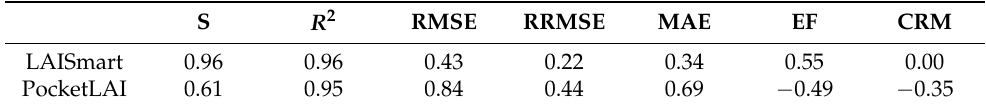
Figure 4. The Q-Q plot of two smartphone sensor methods with the LAI-2000 instrument. The similar quantile-quantile plot around y = x line of LAISmart and LAI-2000 ( a ) indicates that they share a same distribution, while the PocketLAI measurement can’t be taken as a same distribution of LAI-2000 as there is much bias to the y = x line ( b ).